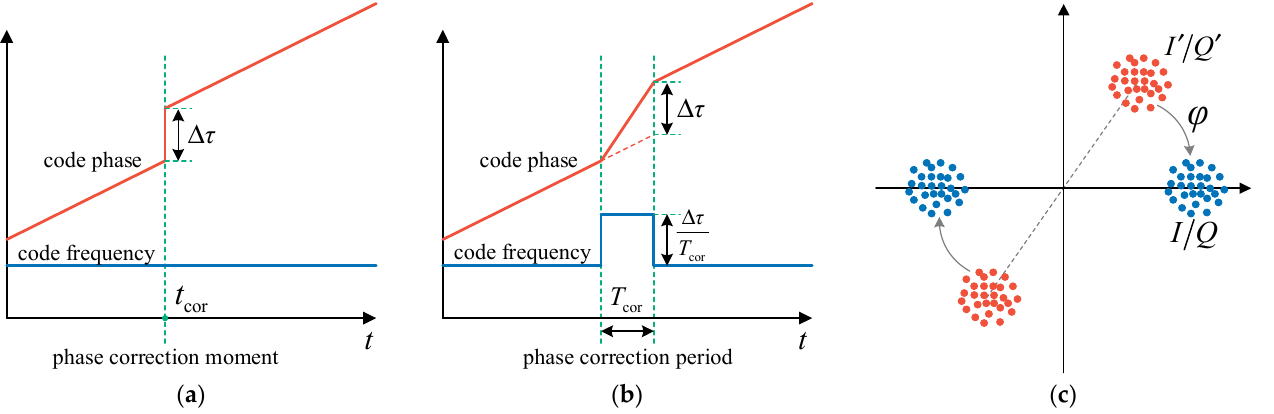
Figure 6. ( a ) Direct code phase correction; ( b ) indirect code phase correction; ( c ) carrier phase correction.